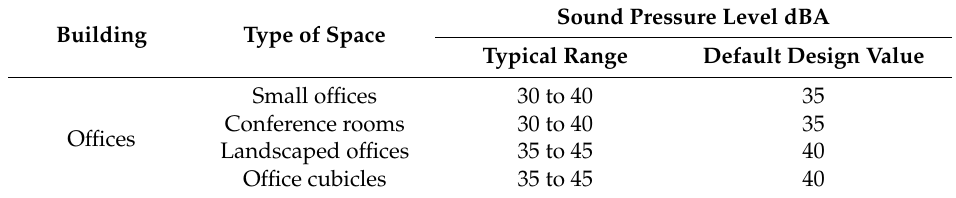
Table 2. Acoustic classification of open plan offices according indoor system noise criteria by EN 15251.EN